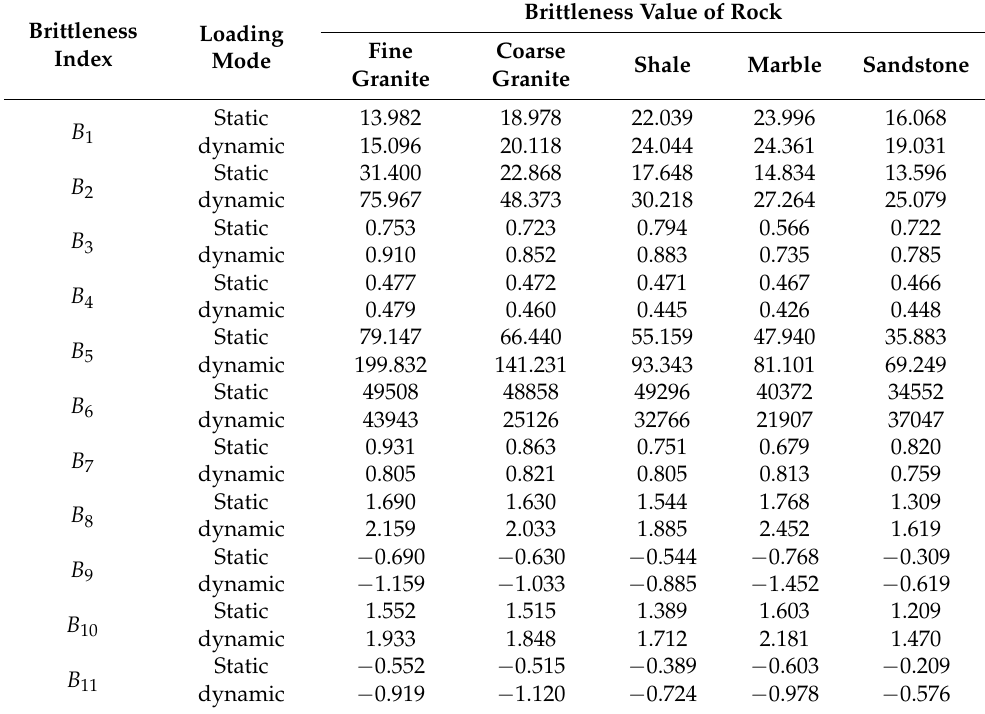
Table 3. Brittleness index values of different rocks under dynamic and static